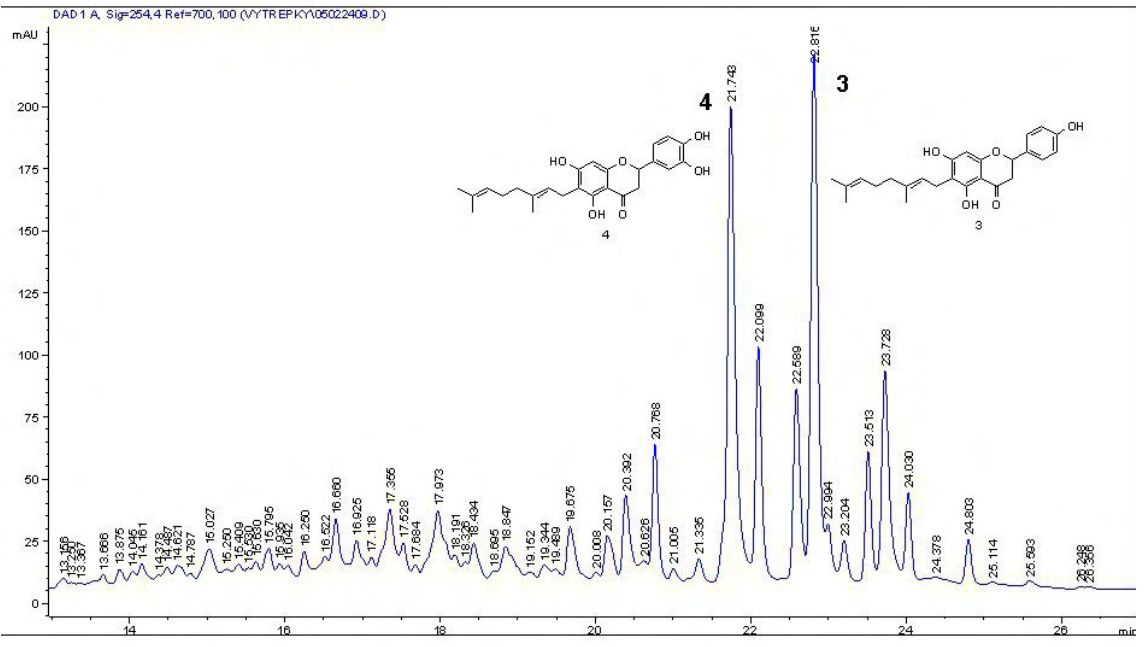
Figure 4 : HPLC chromatograms of the MeOH extract of P. tomentosa fruits, 1 mg/mL (10 µL injection): mimulone ( 3 ), diplacone ( 4